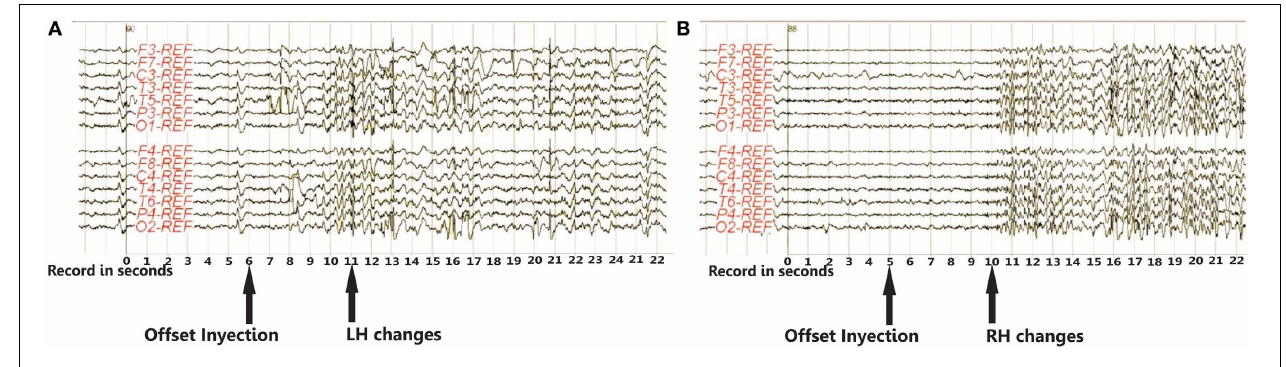
FIGURE 3 | EEG activity recorded from 6s. after propofol injection in the left hemisphere (A) and from 5s. in the right hemisphere (B). Both EEG recordings show bilateral theta-delta slowing and theta band activity peaks post injection, which